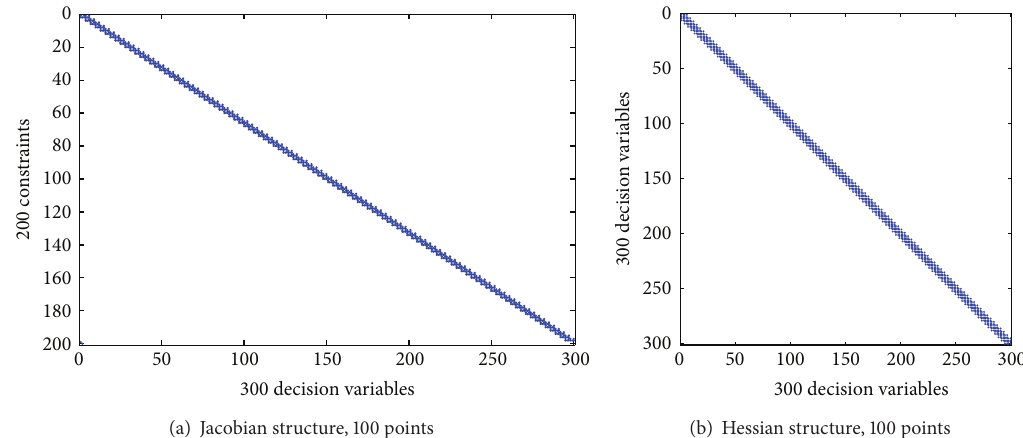
Figure 9: Jacobian and Hessian structures.